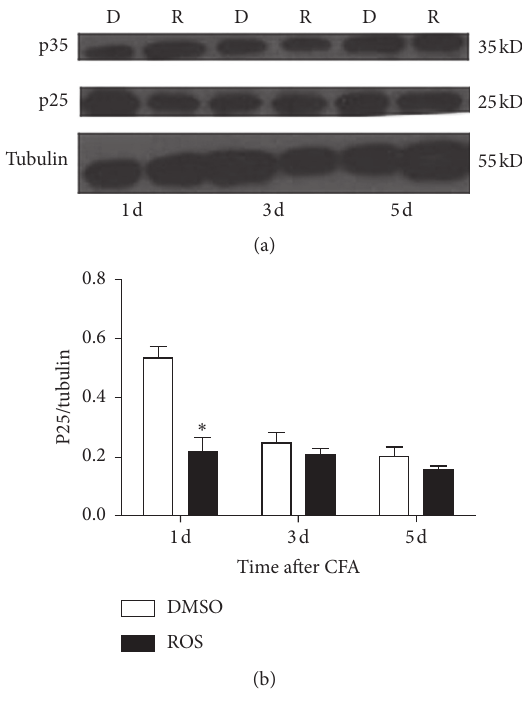
Figure 6: p25 not p35 was significantly reduced by roscovitine via p25 not p35. Compared with controls by intrathecal injection of DMSO in the group treated with intraplantar injection of CFA, the increased expression of p25 protein was significantly reduced by intrathecal injection of roscovitine in the group treated with intraplantar injection of CFA day 1. However, the administration of roscovitine produced no significant effects on p35 protein ex- pression in the same group. Data shown represent mean ± SEM; ∗ P < 0 . 05; n � 4/group